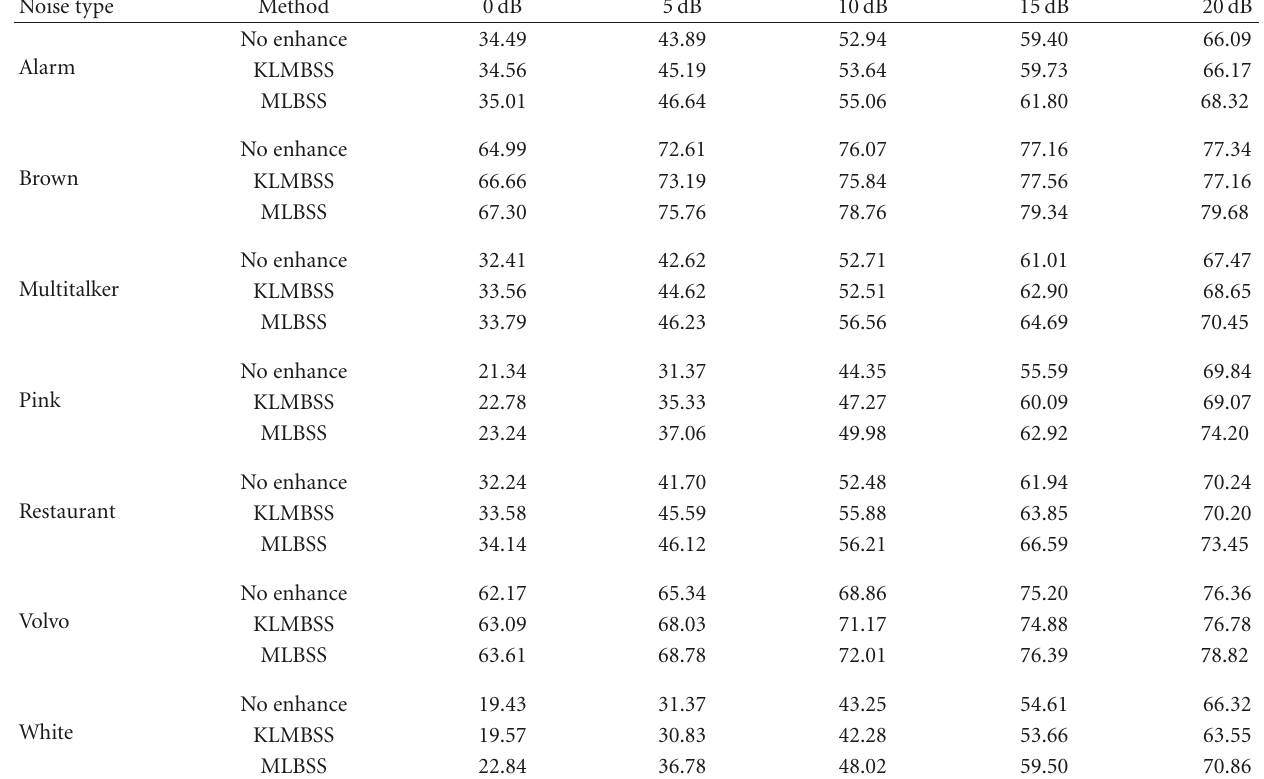
Table 1: Phoneme recognition accuracy (%) on FARSDAT database.